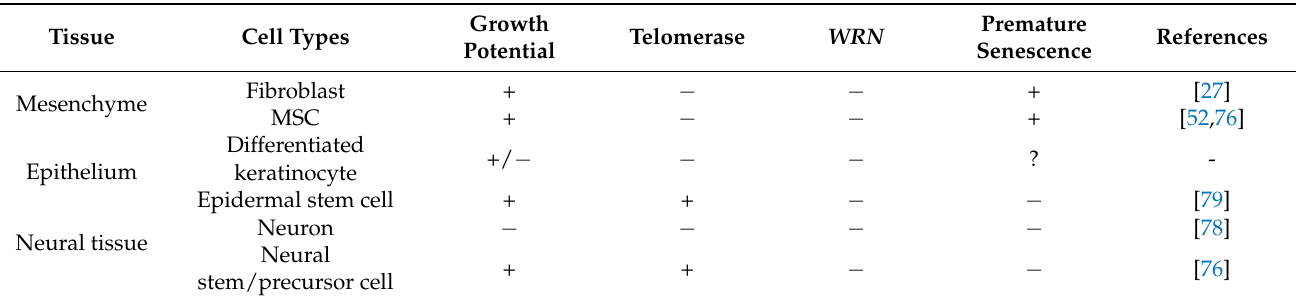
Table 1. Is the premature aging phenotype associated with the premature senescence of cells of mesenchymal, epithelial, or neural origin?